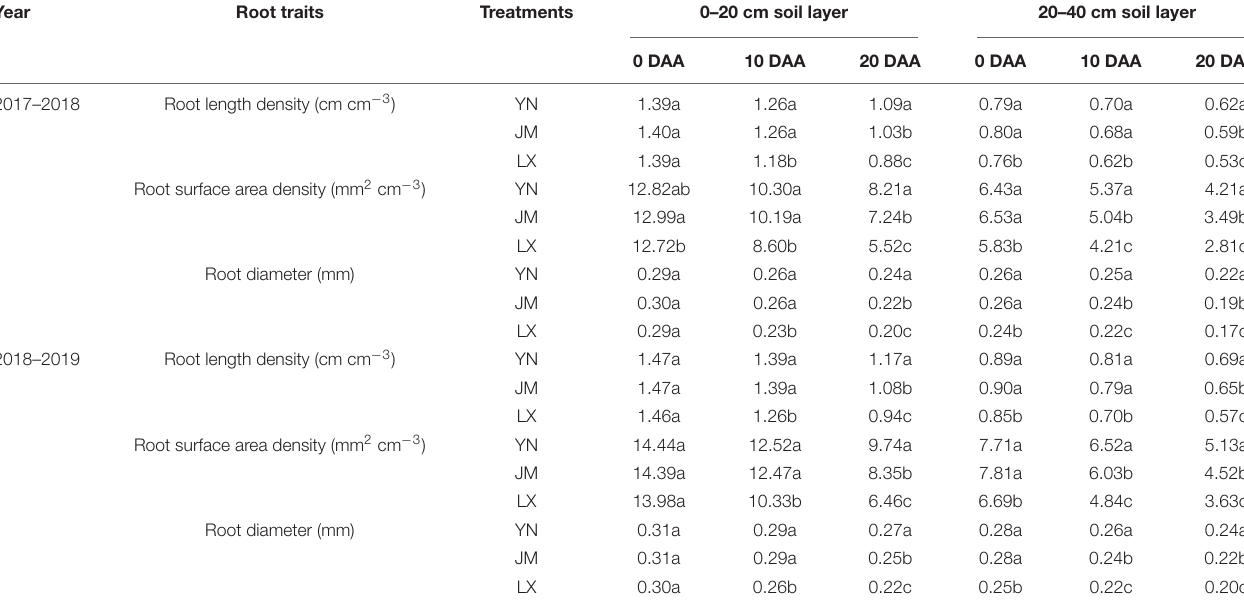
FIGURE 3 | Root weight density in the 0–100 cm soil layer at anthesis of wheat varieties in the 2017–2018 (A) and 2018–2019 (B) growing seasons. YN, Yannong 1212; JM, Jimai 22; LX, Liangxing 99. The different letters in the figure indicate significant differences (Duncan’s test, p < 0.05). Vertical bars represent the SD of the means. TABLE 2 | Root morphology characteristics of winter wheat in the 0–40 cm soil layer after anthesis of wheat varieties in the 2017–2018 and 2018–2019 growing seasons. Year Root traits